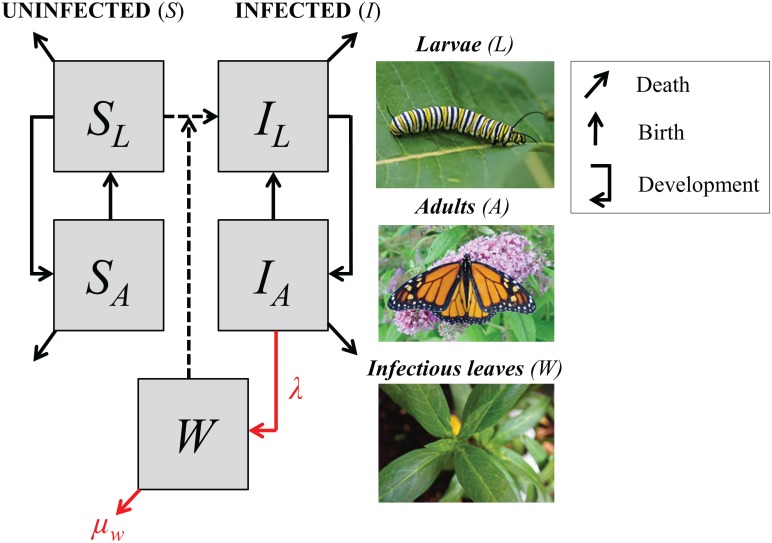
Schematic of model representing protozoan pathogen transmission in monarch hosts.Monarchs are represented as uninfected or infected immature stages (SL or IL) or adults (SA or IA). Milkweed leaves with spores (W) arise when infectious parasite doses are deposited by infected adult monarchs (at rate λ), and are lost through larval consumption (c) or through decay in dose viability (at rate μW). The model assumes that all larvae produced by infected adult females (IA) are born with infections (IL; perfect vertical transmission). Uninfected larvae (SL) can become infected (IL) by consuming leaves with spores (environmental transmission, dashed line).